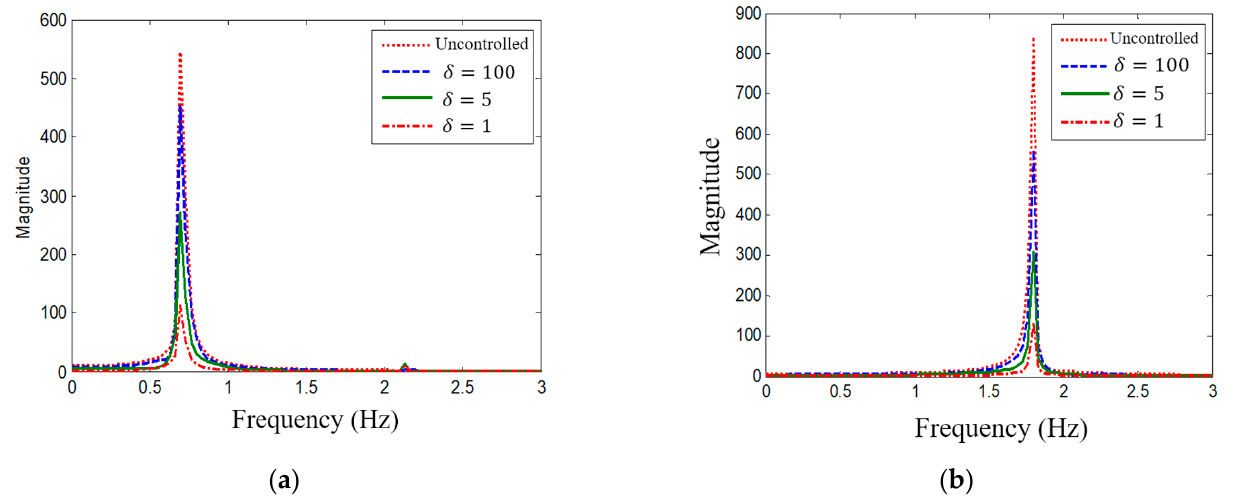
Figure 15. Acceleration response of FFT analysis. ( a ) SDOF (=0.71, ξ = 0.05); ( b ) 4-DOF (=1.79, ξ = 0.05).